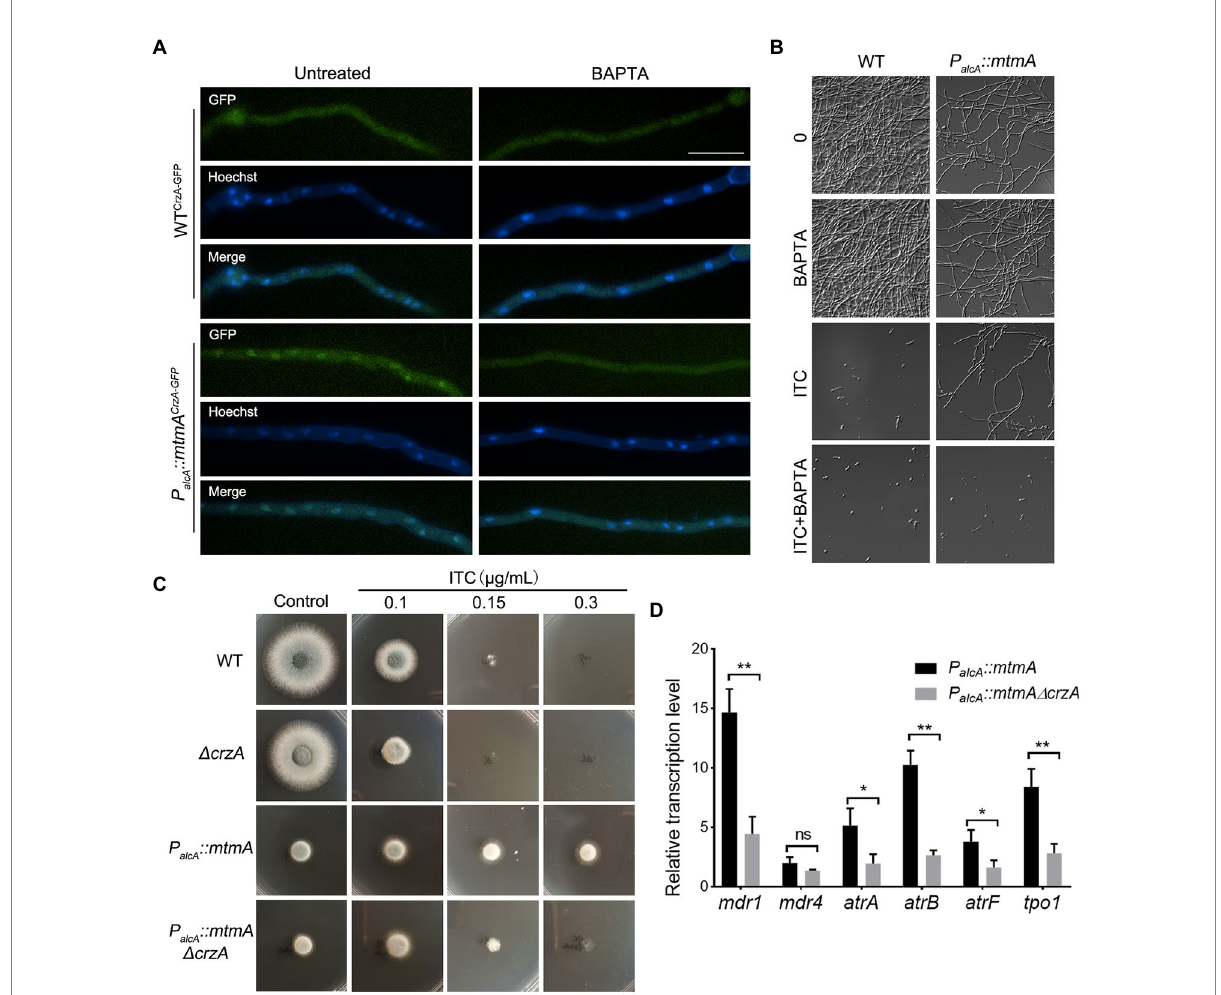
FIGURE 6 Repressed expression of MtmA causes persistent nuclear localization of CrzA, which contributes to drug resistance. (A) Fluorescence images of CrzA-GFP in mycelia under untreated or treated conditions with 30 μ g/ml BAPTA for 30 min in the indicated strains. The merged images of GFP and Hoechst staining showed that CrzA-GFP was localized in the cytoplasm when treated with BAPTA. The scale bar represents 10 μ m. (B) Germlings and hyphal growth phenotypes in the indicated strains under liquid MM treatment with BAPTA (30 μ g/ml), ITC (0.5 μ g/ml) or ITC combined with BAPTA at 37 ° C for 24 h. (C) Conidia of each indicated strain were inoculated on repression (YAG) medium containing serial concentrations of itraconazole (ITC) for 1.5 or 2 days at 37 ° C. (D) The transcript levels of the indicated genes in the indicated strains grown at 37 ° C for 24 h. Error bars indicate the mean ± SD of the results from three independent experiments. Statistical significance was determined by Student’s t test. *, p < 0.05; **, p < 0.01; ns, not